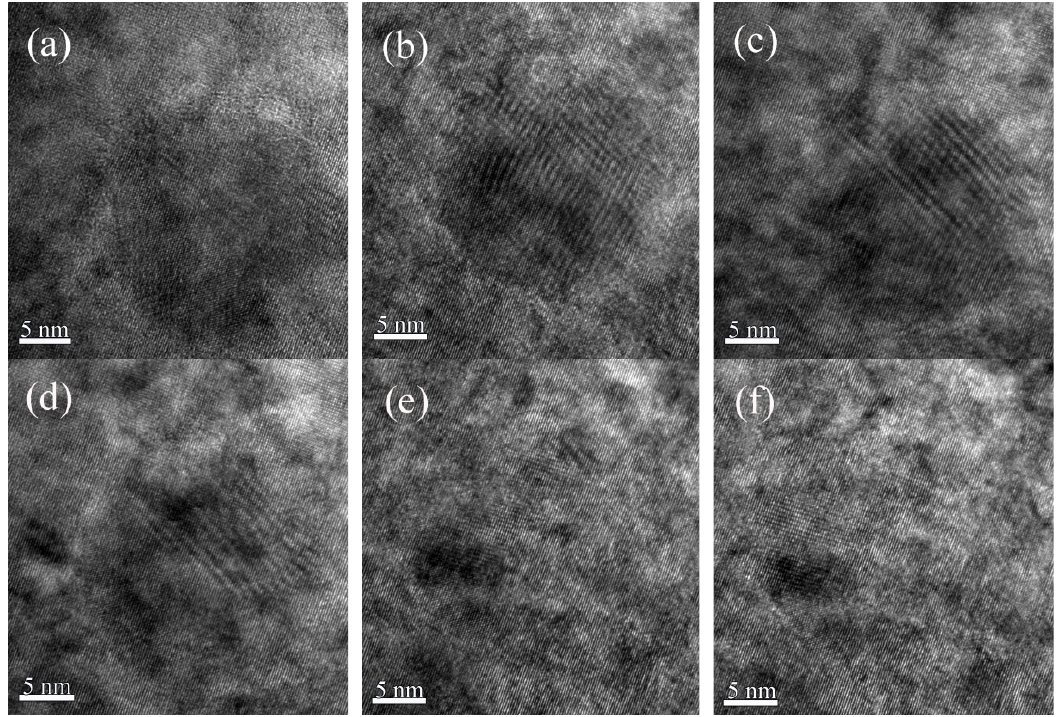
Figure 6. In situ HRTEM image from ( a ) to ( f ) of a single He bubble during TEM observations in high vacuum with per-ten-second capture speed after He ion implantation at 773 K.